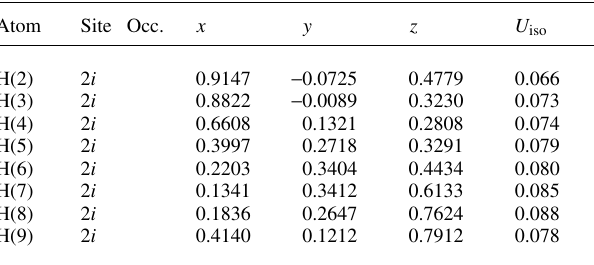
Table 2. Atomic coordinates and displacement parameters (in Å 2 )